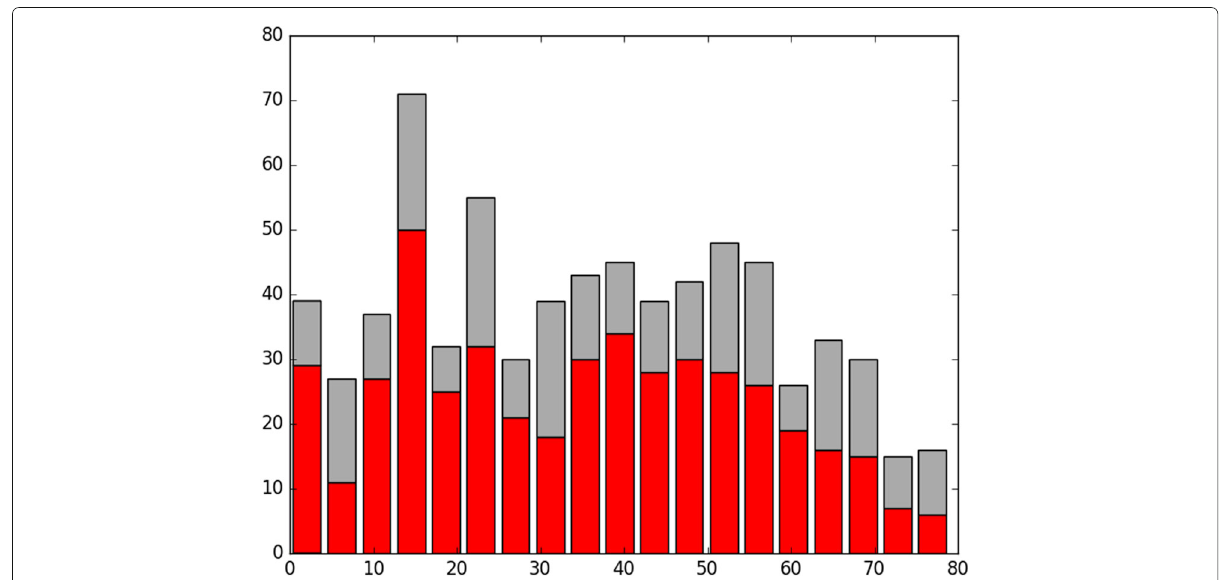
Fig. 5 Alarms: calls made vs canceled. Number of falls that were detected by the system. Red columns represent calls that were escalated to the call center, gray columns those that were canceled by the user